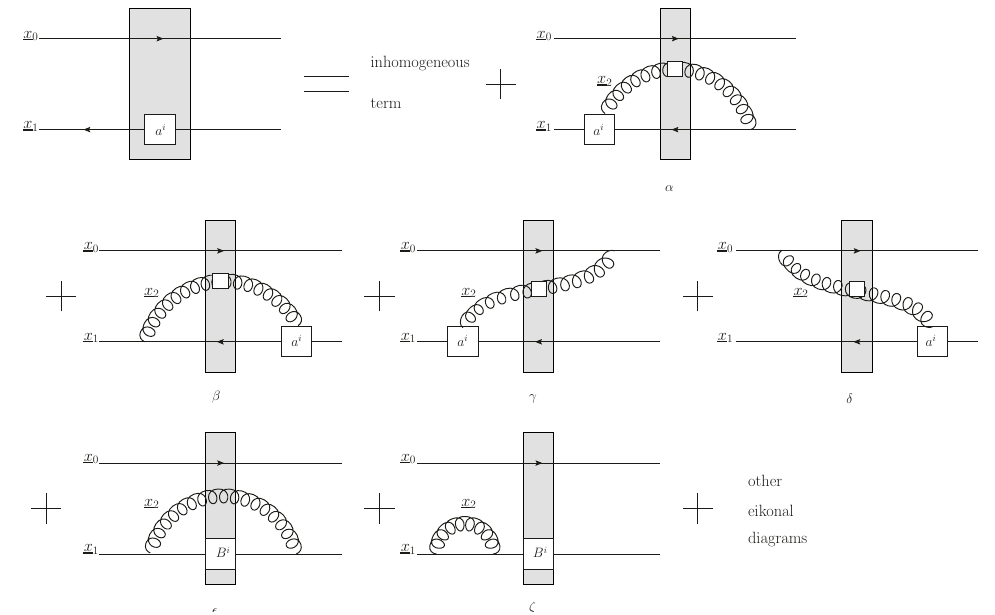
Figure 10. Diagrams illustrating the main types of contractions in the small- x evolution of the polarized dipole amplitude F i from (3.38a). Solid straight lines represent the fundamental Wilson w,ζ lines, the boxes with a i and B i represent the operator insertions in eq. (3.35a), while the box on the gluon line in the shock wave represents an insertion of the entire operator